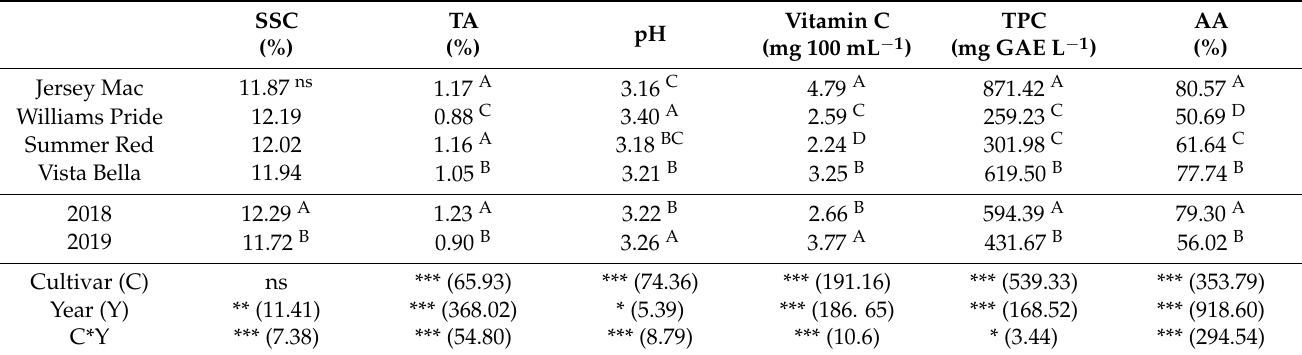
Table 3. Distribution of chemical characteristics by cultivars and